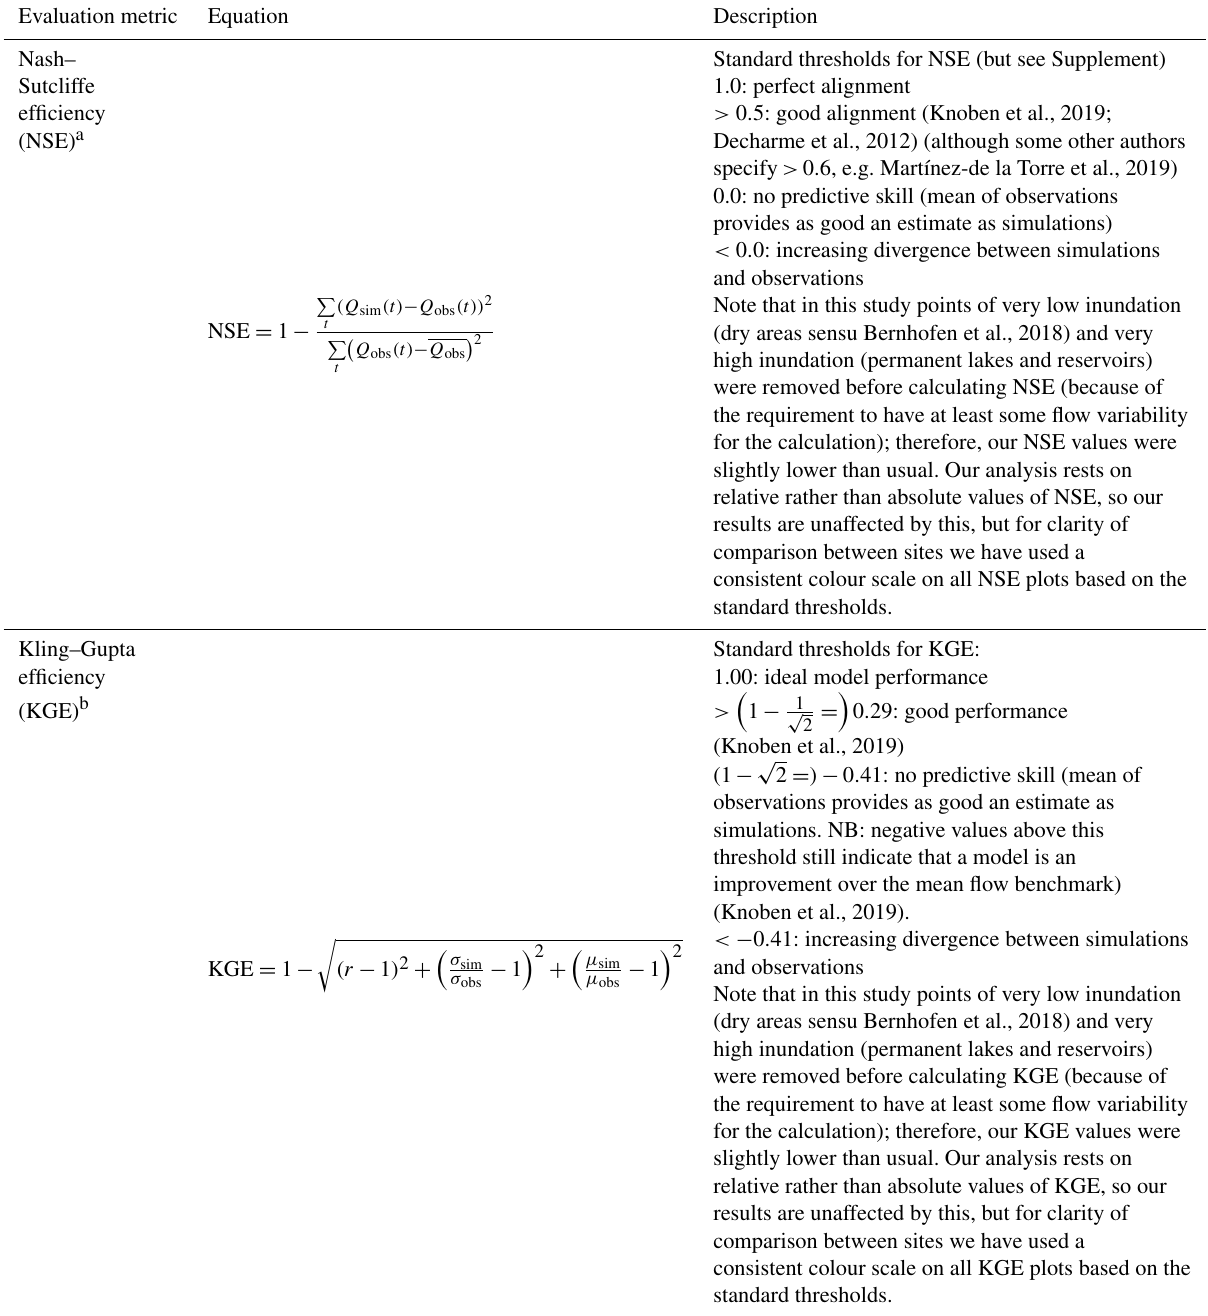
Table 2. Efficiency metrics widely used in flood model assessment and forecast verification (Knoben et al., 2019). In all the equations, Q is the flow variable (e.g. discharge) over time steps t = 1,..., T . Subscripts “obs” and “sim” refer to observed and model-predicted values, respectively, µ obs = Q obs is the observation mean, σ obs = σ sim ), and r is the Pearson correlation coefficient between observed and simulated